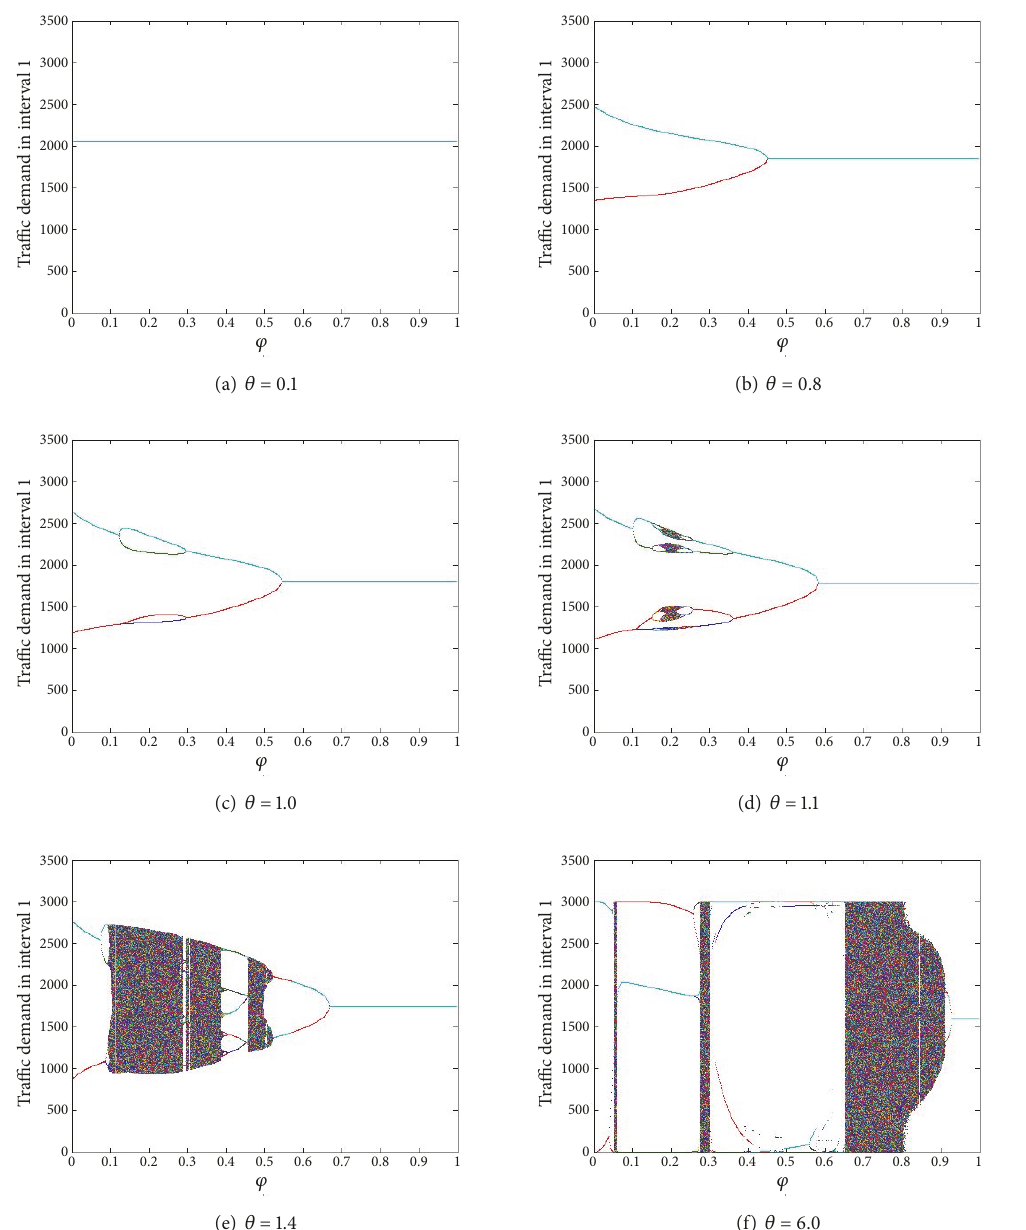
Figure 4: Demand bifurcation diagram with 𝜑 for 𝛼 = 1, 𝜆 = 0.4 for different 𝜃